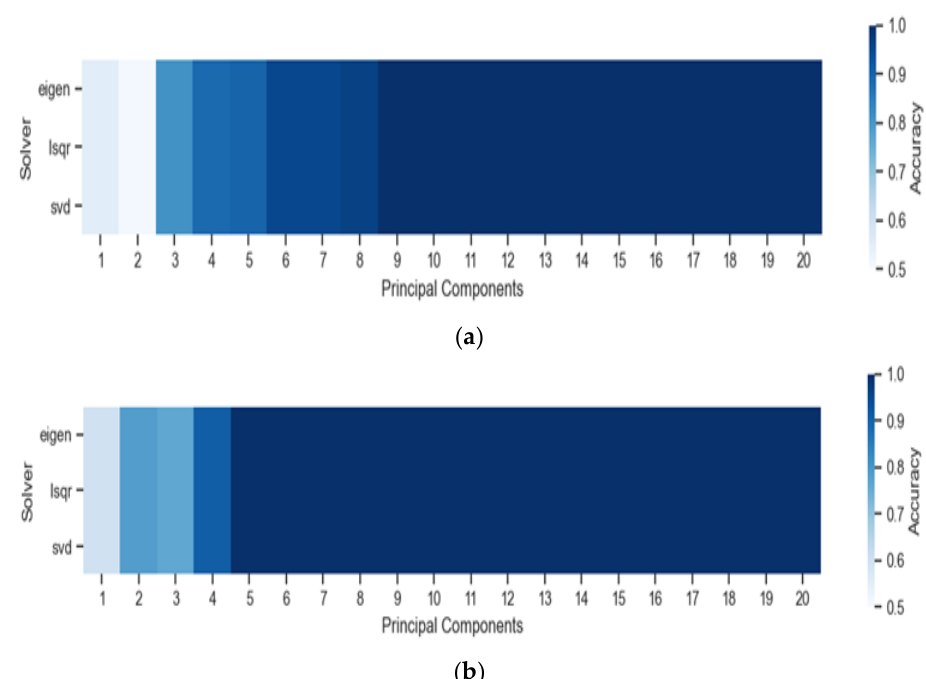
Figure 4. Optimization of the “ PC ” and “ Solver ” parameters in the ( a ) UV and ( b ) VIS region for the LDA algorithm.